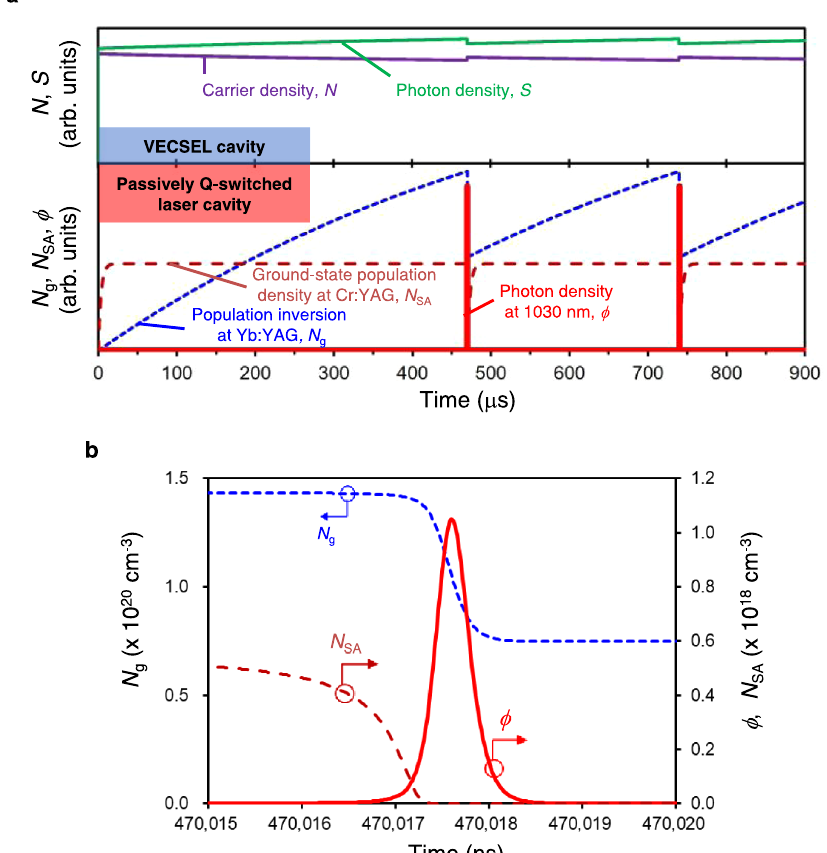
Fig. 3 | Simulation results of the simultaneous rate equations model. a (top) Temporal dynamics of the carrier and photon densities at 940nm in the VECSEL cavity;(bottom)temporaldynamicsofthepopulationinversiondensityatYb:YAG, ground-state population density at Cr:YAG, and photon density at 1030nm in the